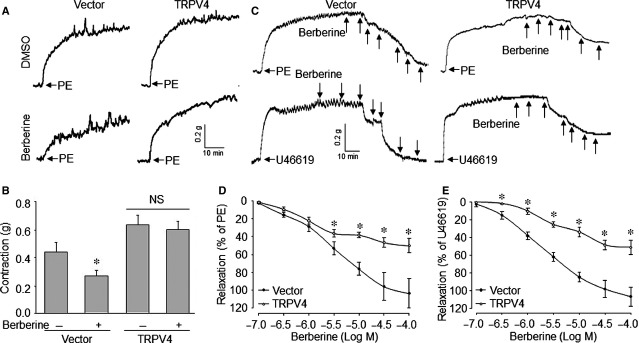
Overexpression of TRPV4 inhibits berberine-induced relaxation in mice aortas. Aortas from mice infected with adenovirus of containing vector or TRPV4 cDNA for 4 weeks were cut into rings and were mounted in organ chamber to detect vessel bioactivity. (A) Aortic ring was incubated with berberine (10 μM) for 60 min. followed by stimulation with PE (1 μM). The contraction of aortic ring was recorded by a computer. The representative tracing of aortic ring contraction was shown from six mice. (B) Summary data for the effects of berberine on aortic contraction in A. Quantitative results are expressed as mean ± SEM, N is 6 mice in each group. *P < 0.05 versus Vector alone. NS indicates no significant difference. (C) The contraction of aortic ring in organ chamber was induced by PE (1 μM) or U46619 (30 nM). Berberine was added into organ bath as indicated dose when the contraction was in the peak. The representative tracing of berberine-induced relaxation on aortic ring was shown from six mice. (D) Summary data for berberine-induced relaxation in PE-stimulated aorta in C. (E) Summary data for berberine-induced relaxation in U46619-stimulated aorta in C. Quantitative results are expressed as mean ± SEM 6 mice were in each group. *P < 0.05 versus Vector.